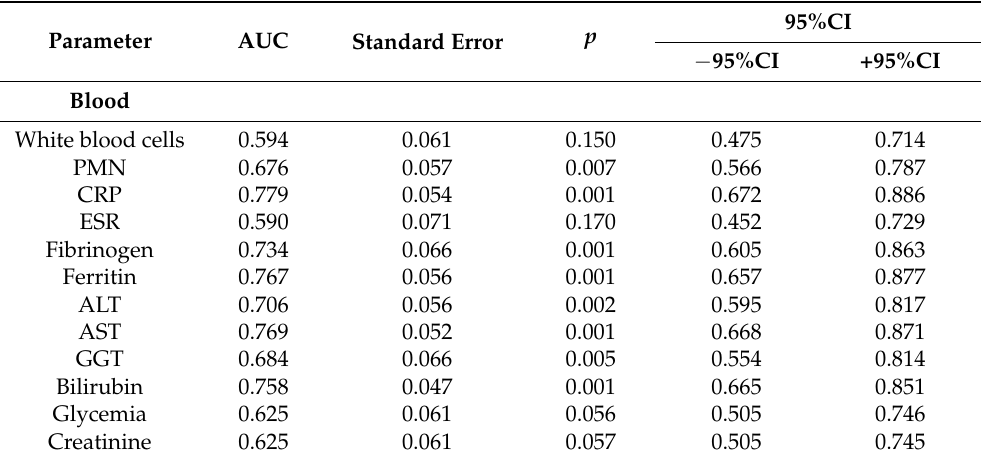
Table 6. The sensibility/specificity balance of laboratory parameters in predicting pneumonia in patients with SARS CoV-2.